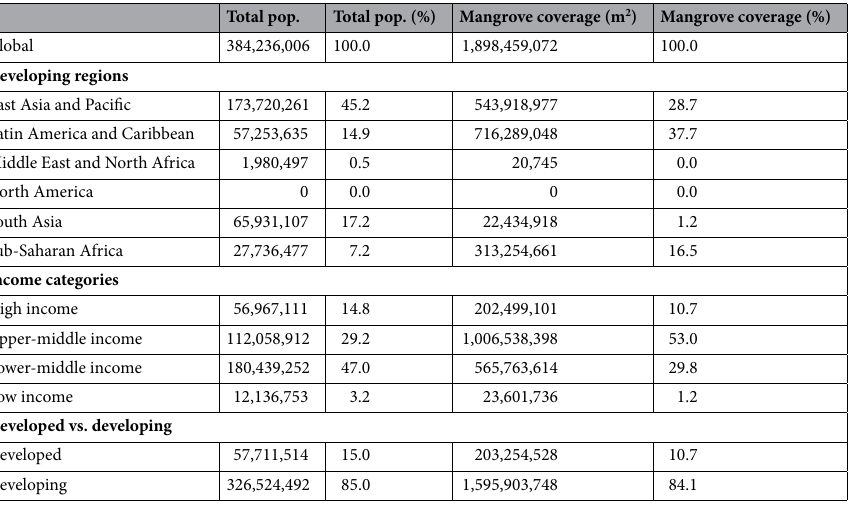
Table 2. 2010 sample total population and mangrove coverage summary statistics for full sample of 102 territories and countries and 2549 coastal communities. Country-level data are included in supplementary materials. Categories are based on World Bank Country and Lending Groups current for the 2019 fiscal year (see https:// datah elpde sk. world bank. org/ knowl edgeb ase/ artic les/ 906519- world- bank- count ry- and- lendi ng- groups). Low income countries are those with a Gross National Income (GNI) per capita less than $995, lower- middle income countries have a GNI/pp between $996 and $3895, upper-middle income countries have a GNI/pp between $3896 and $12,056 and upper-middle income countries have a GNI/pp > $12,056. Developing regions exclude countries with high income in their